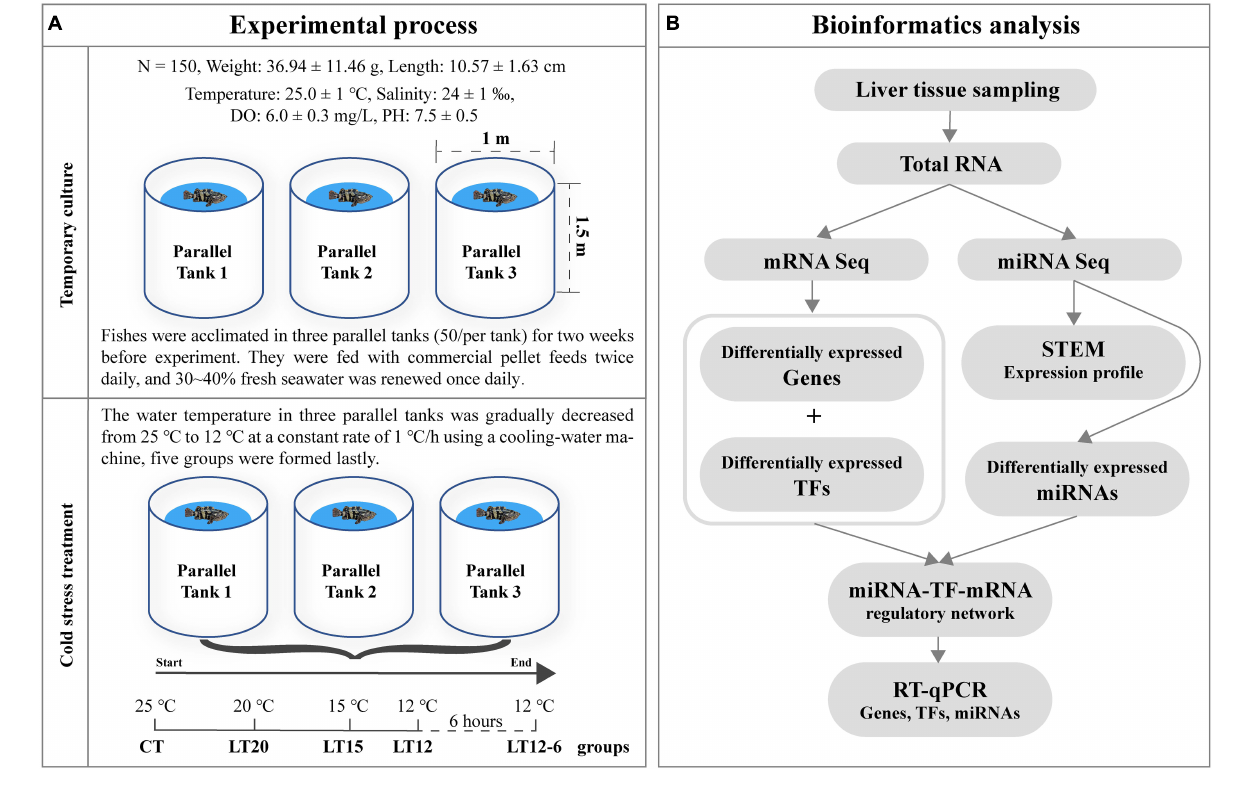
FIGURE 1 | Overview of the experimental process (A) and bioinformatics analysis (B)